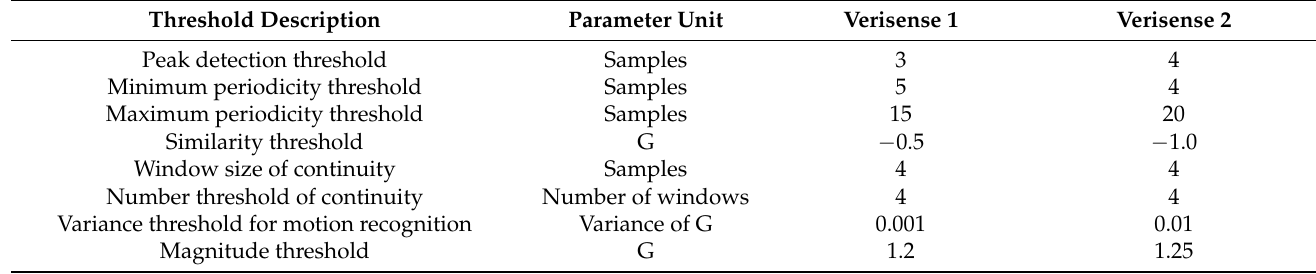
Table 1. Threshold changes between Verisense